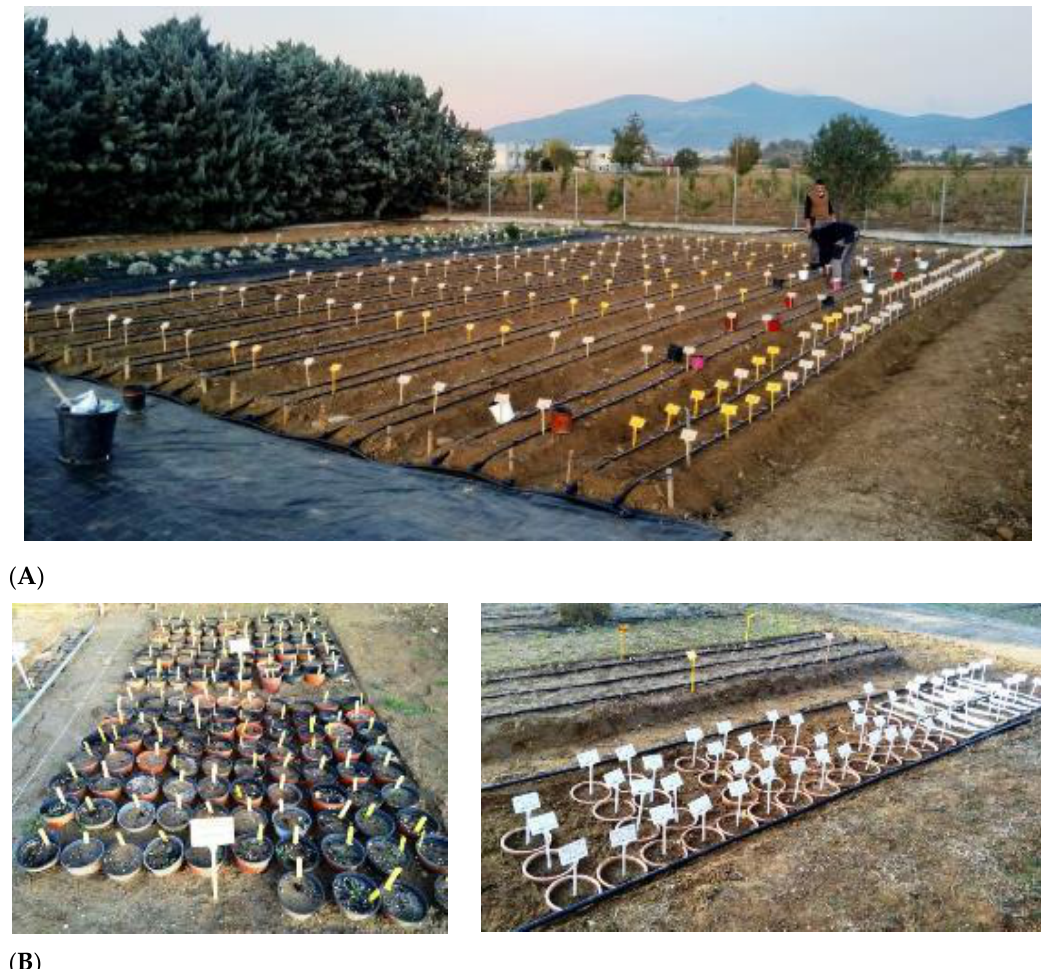
Figure 5. View of the 38 IPEN accessions of wild-growing Greek tulips belonging to 13 species (see Table 1) planted in the field ( A ) and in submerged pots ( B ) during autumn 2020 at the premises of the Institute of Plant Breeding and Genetic Resources in Thermi, Thessaloniki, Northern Greece for ex situ conservation and first experimentation in the frame of the research project